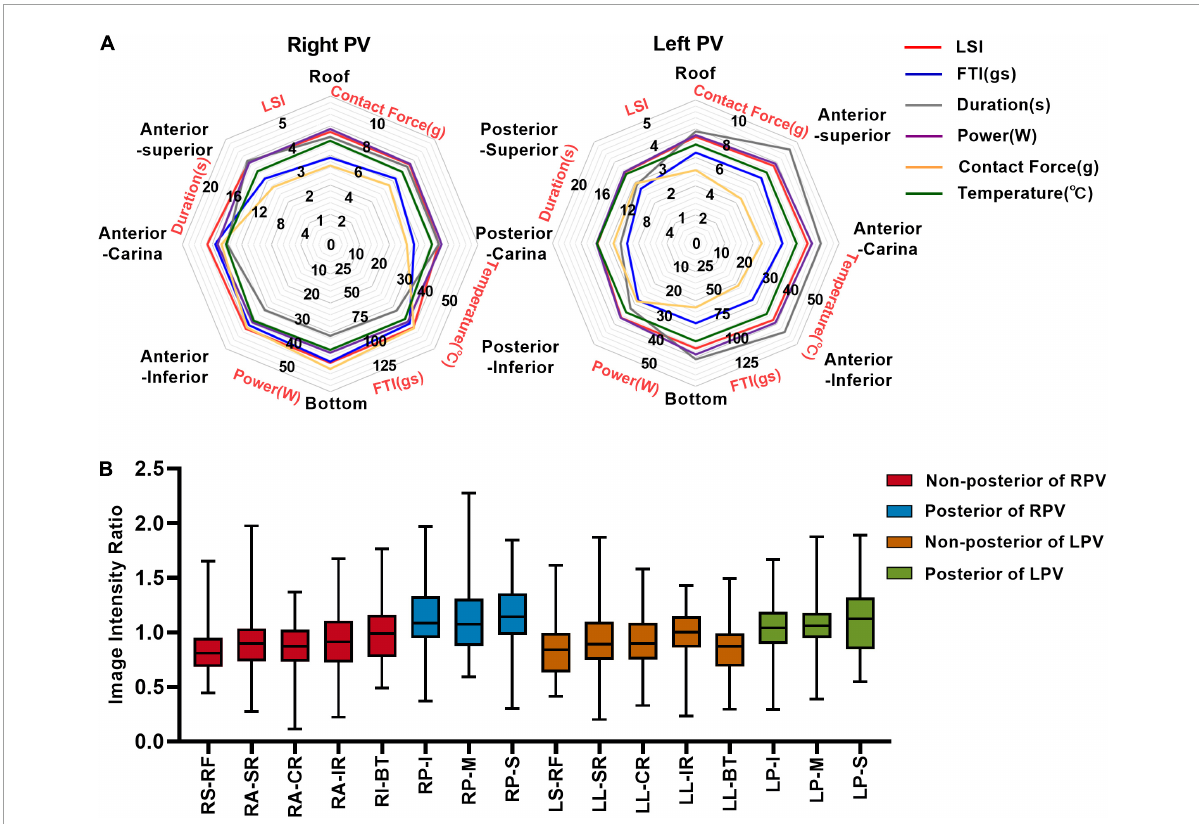
FIGURE4 Image intensity ratio and ablation parameters of each PV segment under the ablation line. (A) The distribution of LSI, FTI, duration, power, contact force, and temperature at each segment of PV. (B) Myocardial wall image intensity ratio of each PV segment under ablation line. LSI, lesion size index; FTI, force–time integral; R-R, right roof; R-AS, right anterior superior; R-AC, right anterior carina; R-AI, right anterior inferior; R-B, right bottom; R-PI, right posterior inferior; R-PC, right posterior carina; R-PS, right posterior superior; L-R, left roof; L-AS, left anterior superior; L-AC, left anterior carina; L-AI, left anterior inferior; L-B, left bottom; L-PI, left posterior inferior; L-PC, left posterior carina; L-PS, left posterior superior; RPV, right pulmonary vein; LPV, left pulmonary